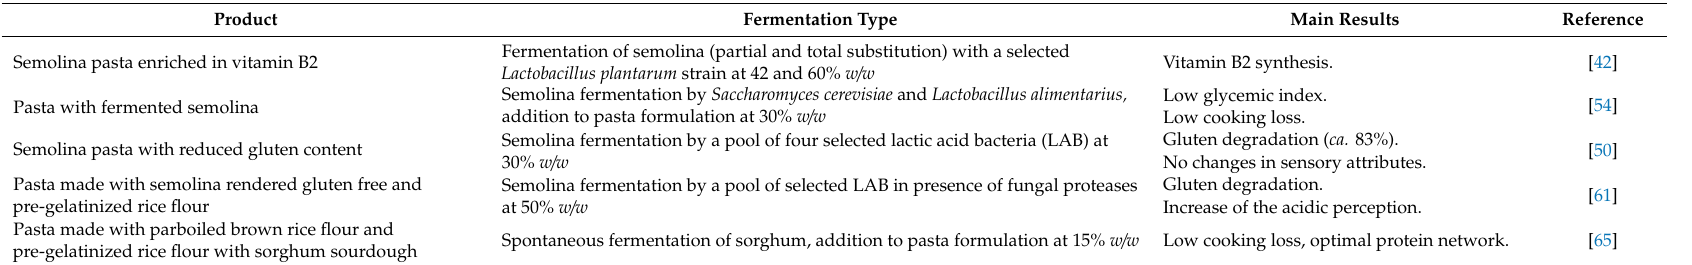
Table 1. Non-exhaustive survey of the pasta products including fermentation step of semolina or non-wheat flours mixtures. The main nutritional and functional improvements, and the e ff ects on technological and sensory properties, in comparison to conventional pasta, are